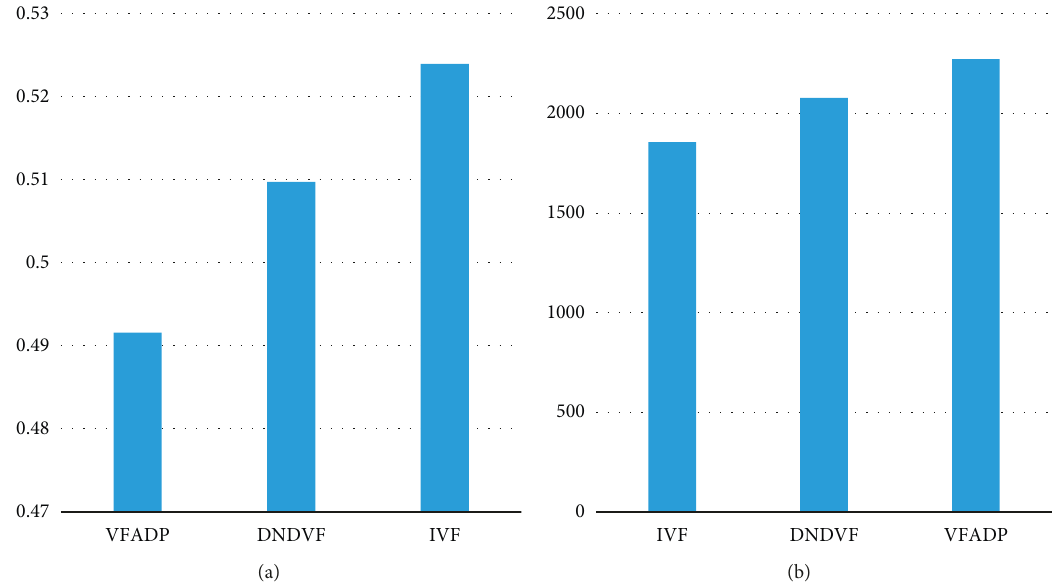
Figure 5: Coverage effect and moving distance in different algorithms when N � 60. (a) Coverage effect. (b) Moving distance